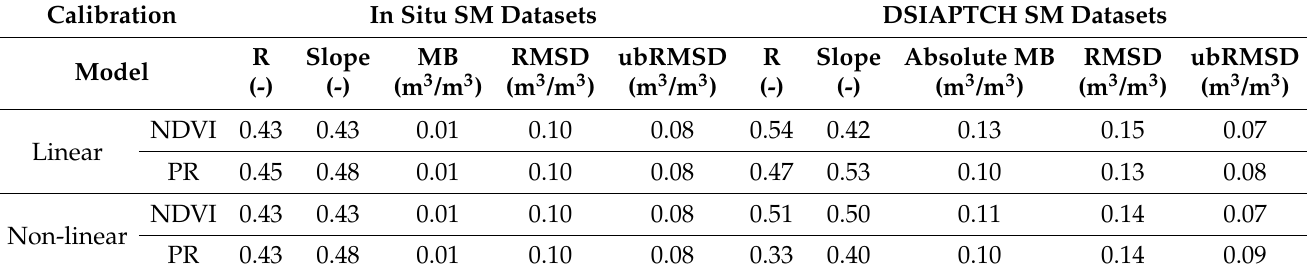
Table 3. Mean statistical results over 22 parcels of R3 irrigated sites in terms of correlation coefficient (R), slope of the linear regression (S), mean bias (MB), RMSD, and ubRMSD between predicted and in situ SM, for linear and non-linear RTM with NDVI and PR as a vegetation descriptor and where in situ (left) and DISPATCH (right) SM datasets are used for calibration